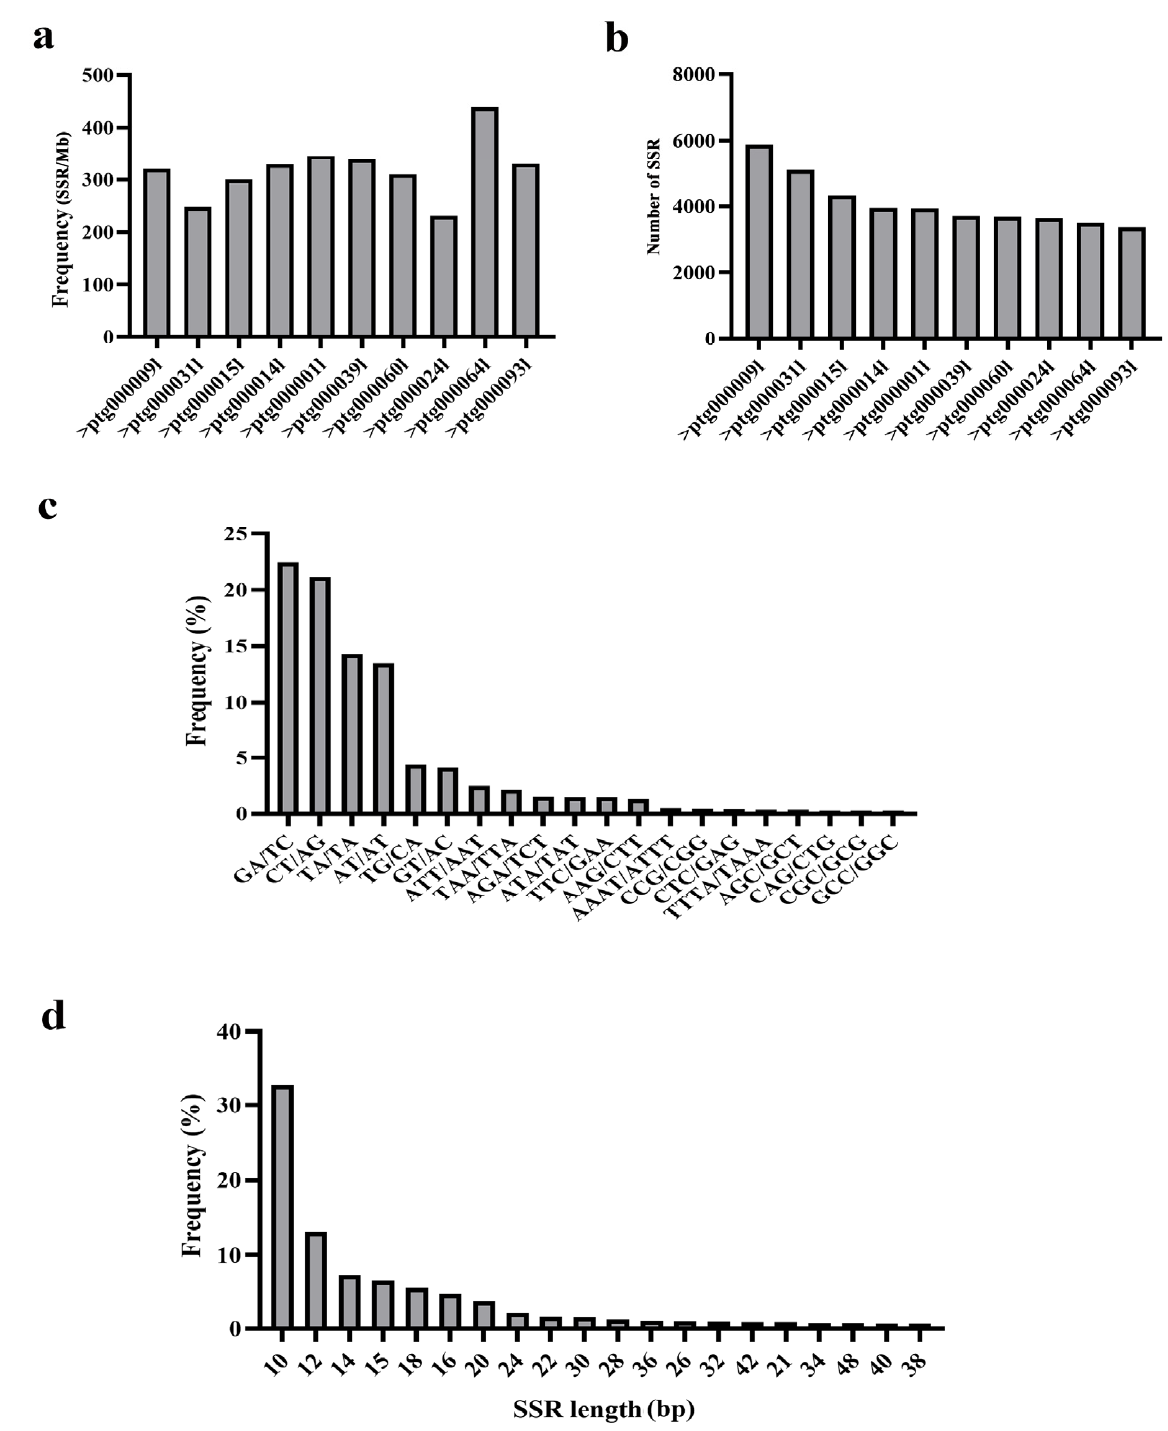
Figure 3. Detection of simple sequence repeat (SSR) loci in the O. vulgare genome. ( a ) Frequency of SSR loci (number of SSR loci per Mb) in the top ten longest contigs. ( b ) Total number of SSR loci on each of the ten longest contigs. ( c ) SSR motif type and frequency. ( d ) Frequency of SSR motifs of different